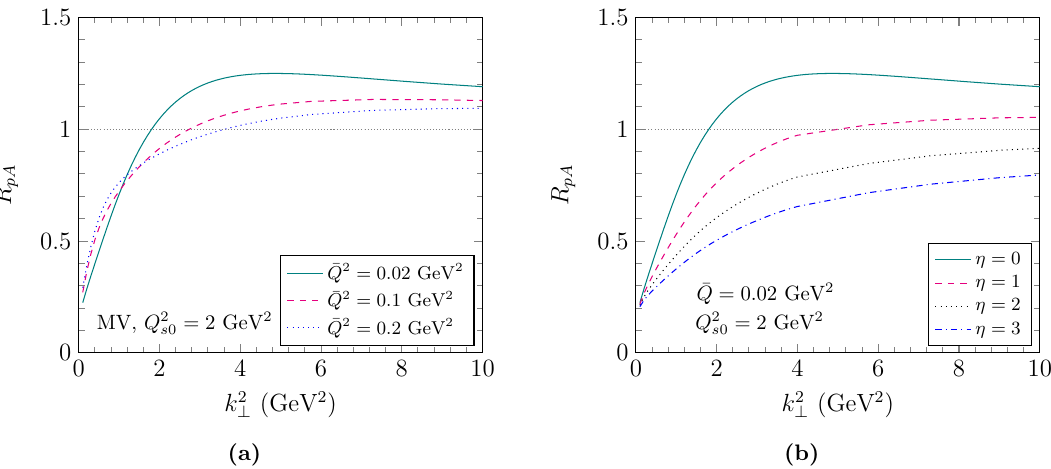
Figure 7. The ratio R pA defined in eq. (3.22), plotted as a function of k 2 model predictions for 3 different values of ¯ Q 2 . For sufficiently small ¯ Q 2 the ratio goes well above 1 at mid transverse momenta. (b) Rapidity evolution of the results from the left plot corresponding to ¯ Q 2 = 0 . 02 GeV 2 . After a couple of rapidity steps the ratio stays below 1 for all values of k 2 under